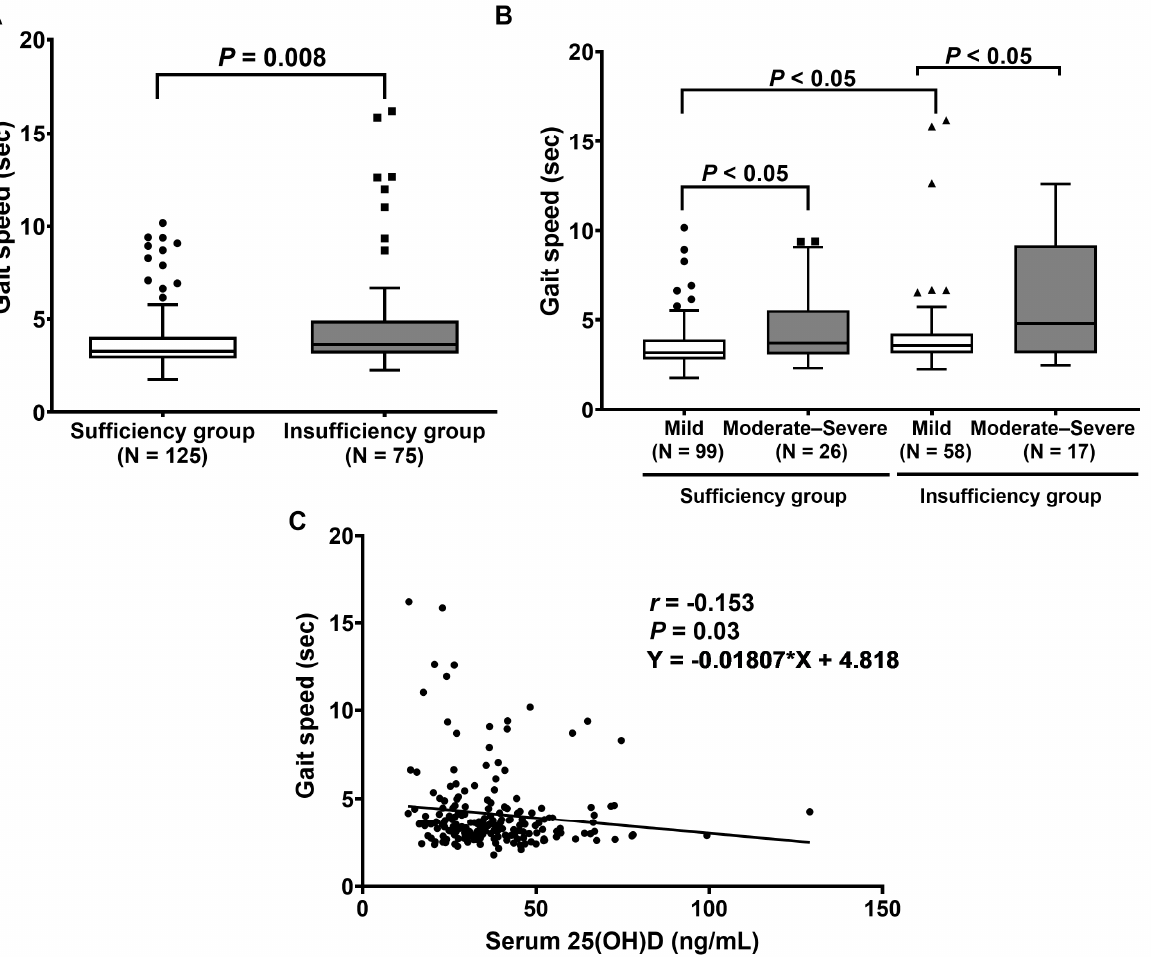
Figure 2. Evaluation of gait speed physical performance: ( A ) Comparison of gait speed between patients with vitamin D sufficiency and insufficiency. p -value was calculated with the Mann–Whitney U test. ( B ) Comparison of gait speed between patients, classified by ODI score. p -value was evaluated by Friedman’s two-way analysis of variance (ANOVA) test. ( C ) Correlation between serum 25(OH)D and gait speed.